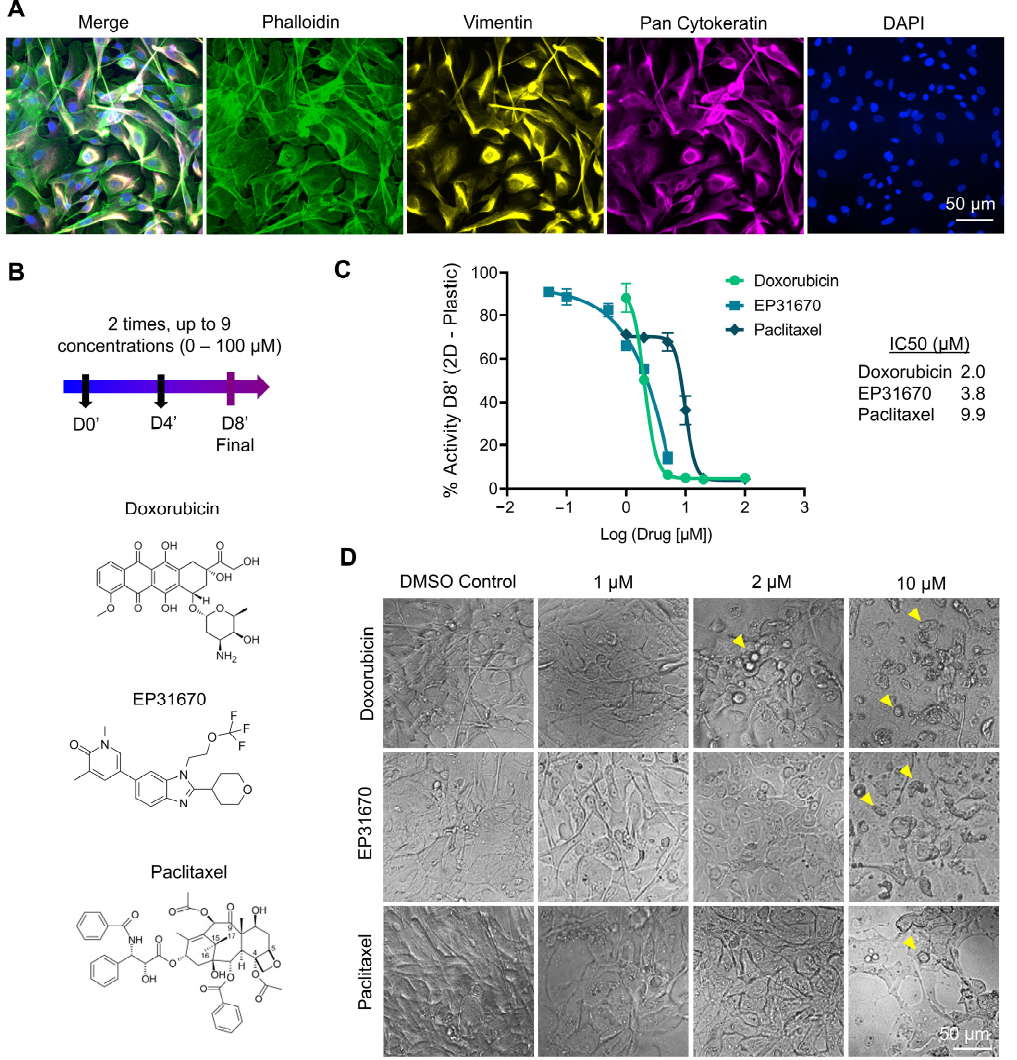
Figure 7. 2D drug response from P#04F patient-derived cells. ( A ) Epifluorescence images from DAPI (blue), pan-cytokeratin (yellow), vimentin (magenta), phalloidin (green) staining epithelial origin of subcultured cells and epithelial-to-mesenchymal transition process. ( B ) Drug treatment schedule and drug structures. ( C ) IC 50 doses responses (Means ± SE, n = 3). ( D ) Brightfield images of cell monolayers after 8 days of treatments. Yellow arrows show cell damage.